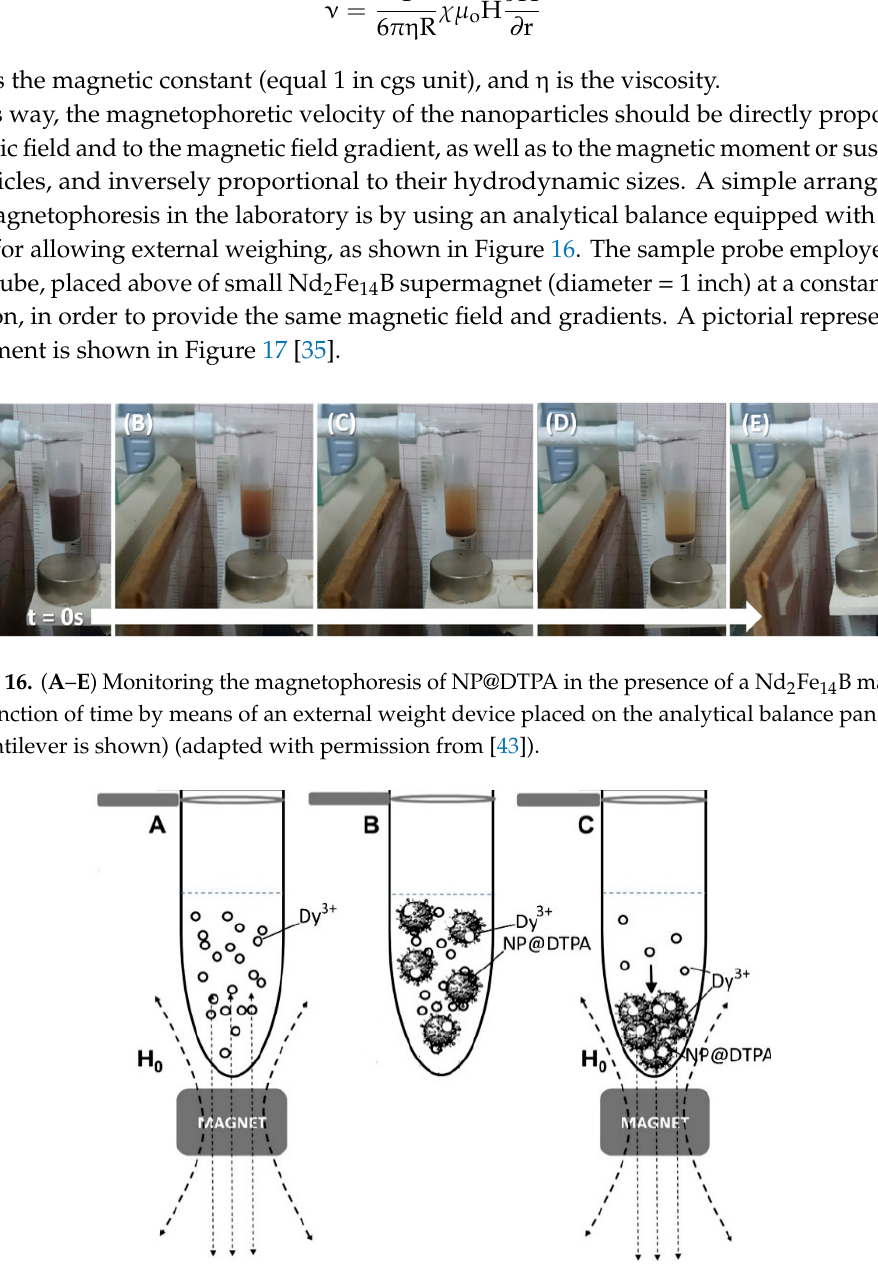
Figure 17. Pictorial representation of the capture of Dy 3+ ions in the presence of the magnet: ( A ) Initial Dy 3+ solution (0.1 mol L − 1 ); ( B ) after adding NP@DTPA and stirring without applying the magnet; ( C ) magnetophoretic deposition after the capture of Dy 3+ ions by the superparamagnetic nanoparticles (adapted with permission from